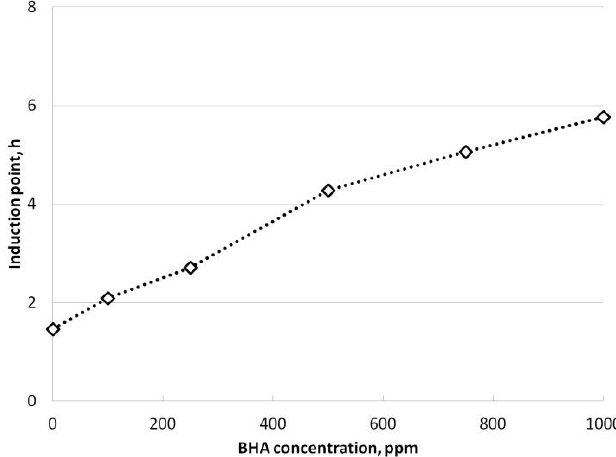
Figure 5. E ff ect of BHA on oxidative stability of sa ffl ower Figure 5. Effect of BHA on oxidative stability of safflower biodiesel.